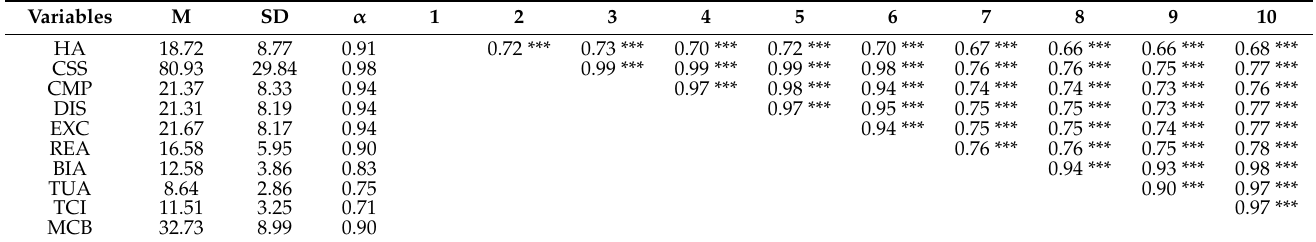
Table 1. Means, standard deviations and correlations among health anxiety, cyberchondria (its constructs), (biased thinking, beliefs about thought uncontrollability, beliefs about thought can cause illness) and metacognitive beliefs ( N = 500).